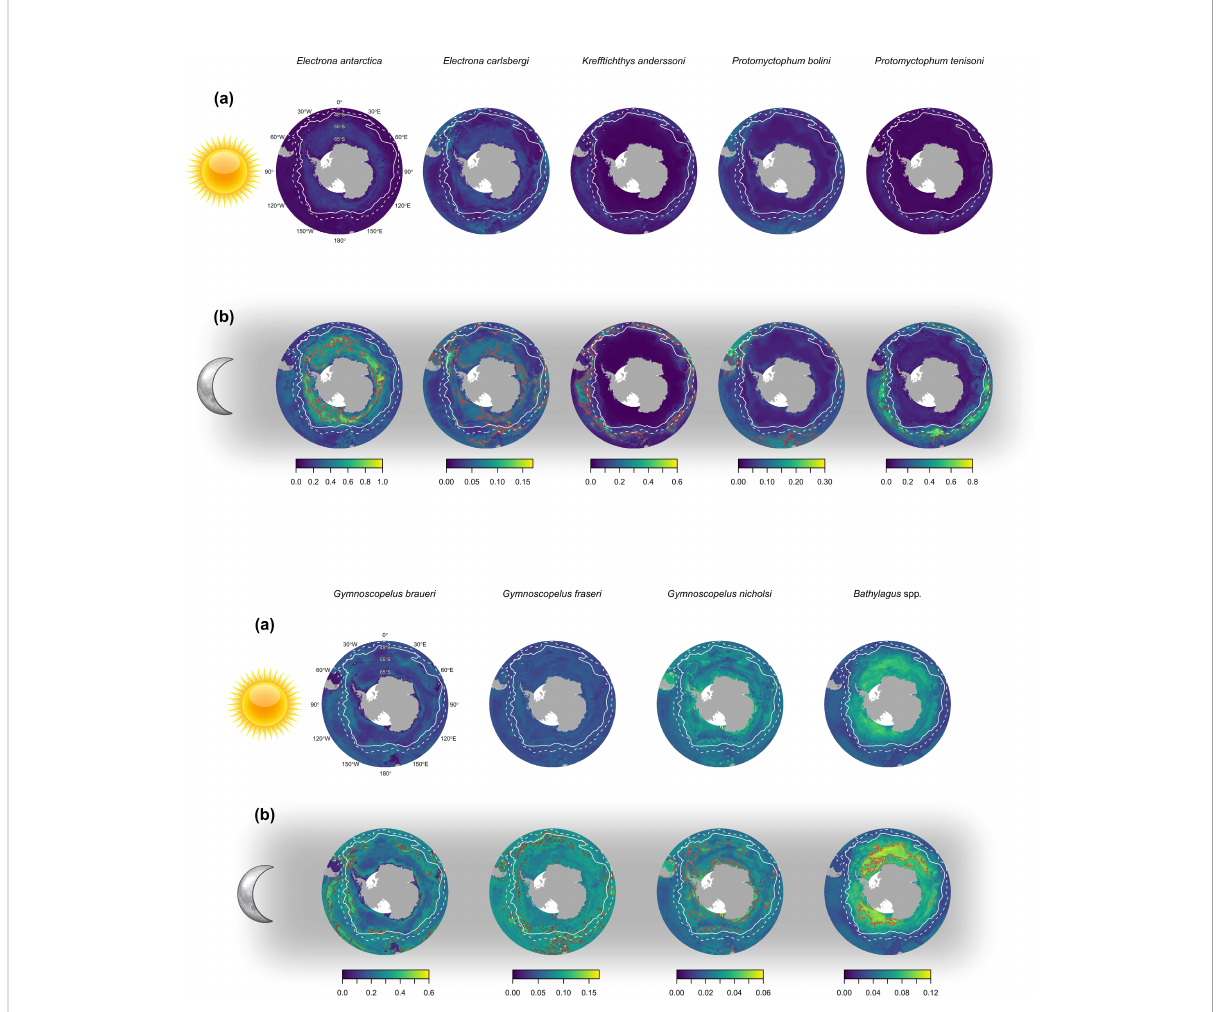
FIGURE 5 The predicted abundance (ind. 1000 m -3 ) of eight species of myctophid and the genus Bathylagus at (a) day and (b) night in the top 200 meters of the water column. The brown outline depicts the 90th percentile (top decile) that represents the most densely distributed 10% of the total abundance for the study area. The white solid line shows the position of the polar front (PF), and the white dashed line shows the position of the sub-Antarctic front (SAF). Predictions are for an RMT 25 with a codend mesh of 5